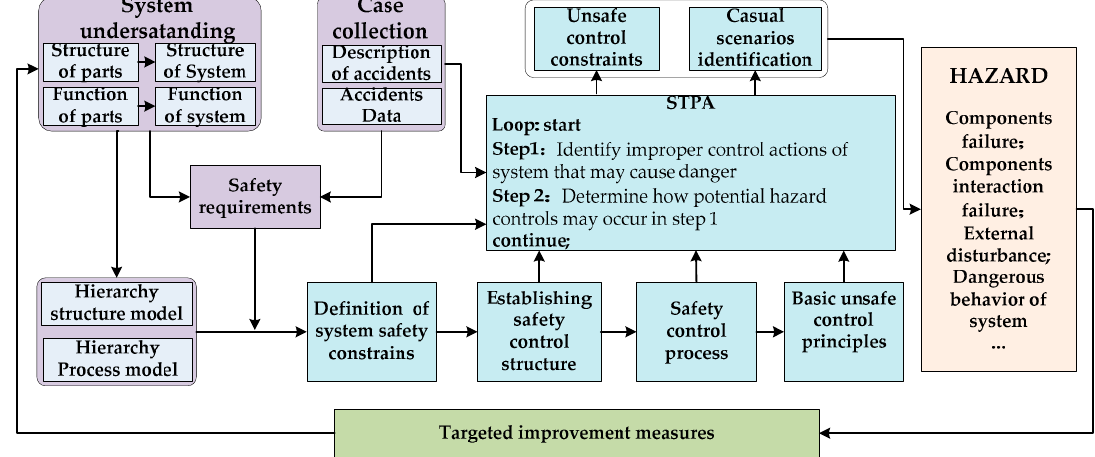
Figure 6. Hazard analysis framework for electromechanical equipment system based on STAMP.